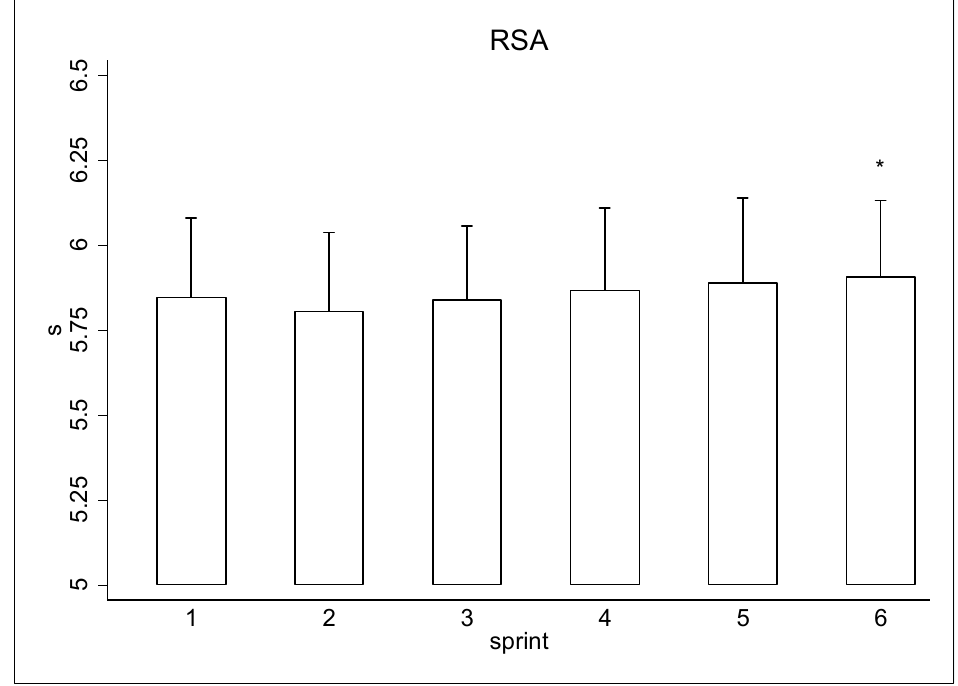
Figure 1. Performance of the RSA test (6 × 40 m) for female field referees. * Significant differences between sprints ( p < 0.05).